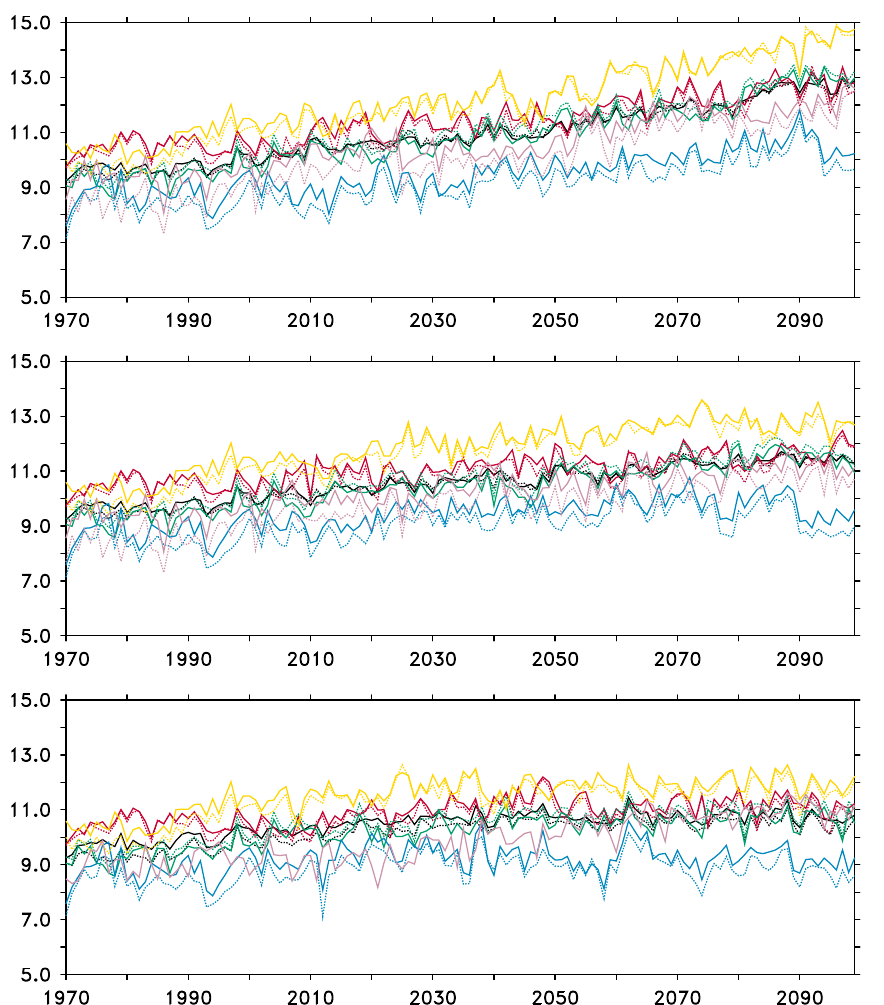
Figure 6. Annual mean SST ( ◦ C) averaged over the North Sea for the RCA4-NEMO (solid lines) and CMIP5 (dotted lines) scenarios RCP8.5 ( top ), RCP4.5 ( middle ), and RCP2.6 ( bottom ). The different lines denote ensemble median (black), MPI-ESM-LR (red), EC-EARTH (green), GFDL-ESM2M (blue), HadGEM2-ES (yellow), and IPSL-CM5A-MR (rose). The rose line in the figure for the RCP2.6